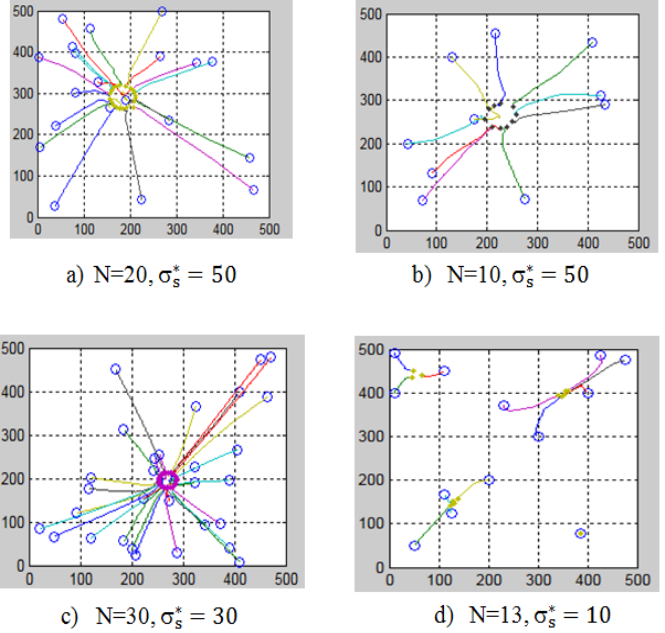
Figure 5. The convergence process of the swarm robot without obstacles.